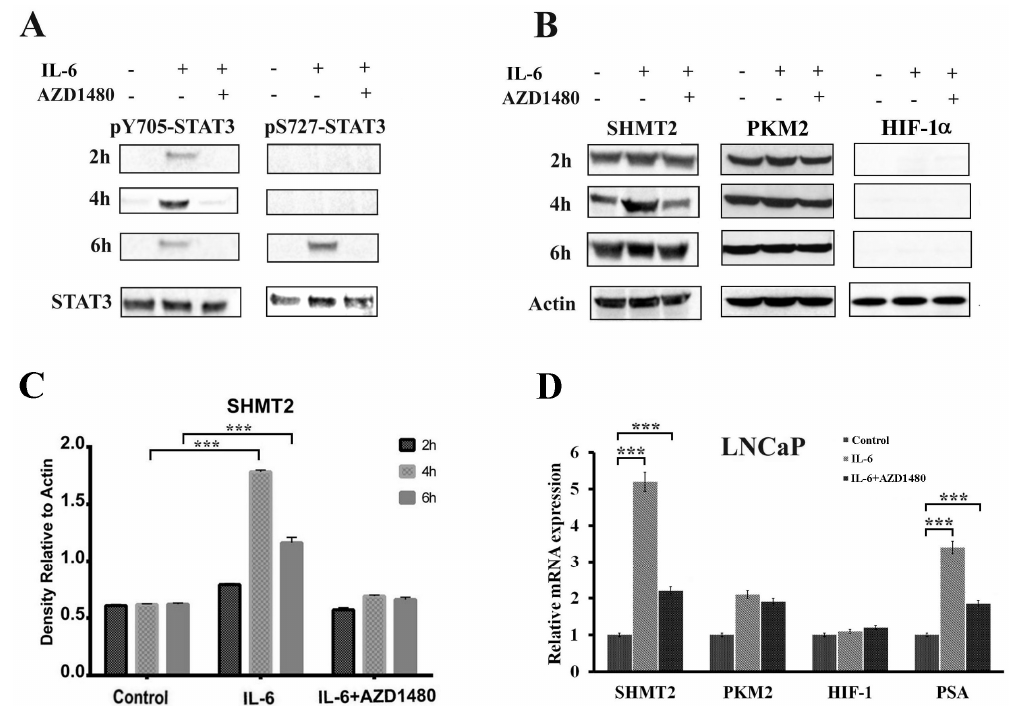
Figure 5. E ff ect of cytokines treatment in LNCaP cell line. ( A , B ) Western blot analysis of total protein extracts in a time course experiment on LNCaP cells, treated with IL-6 in presence or absence of a JAK2 inhibitor (AZD-1480). Samples were analyzed for STAT3 phosphorylation, both Y705 and S727 ( A ) and SHMT2, PKM2, and HIF-1 α ( B ). The experiment was repeated three times and a representative blot is shown. ( C ) Quantification of SHMT2 levels by densitometric analysis of immunoblots. For each sample, proteins were quantified and values normalized against the β -actin level presents in the same sample and taken as housekeeping control. Data were plotted as mean ± SD of three separate experiments. Asterisks indicate significant di ff erences vs. control (*** p < 0.001). ( D ) RT-PCR analysis of PKM2, SHMT2, HIF-1 α , and PSA expression levels in LNCaP cells after 4 h of IL-6 stimulation. The expression values were normalized to a housekeeping gene ( β -actin) and expression level of untreated cells has been set to 1. Each value is the average of three experiments ± SD (*** p < 0.001). Table 1. GSH and GSSG content measured in LNCaP cells subjected to di ff erent treatments.